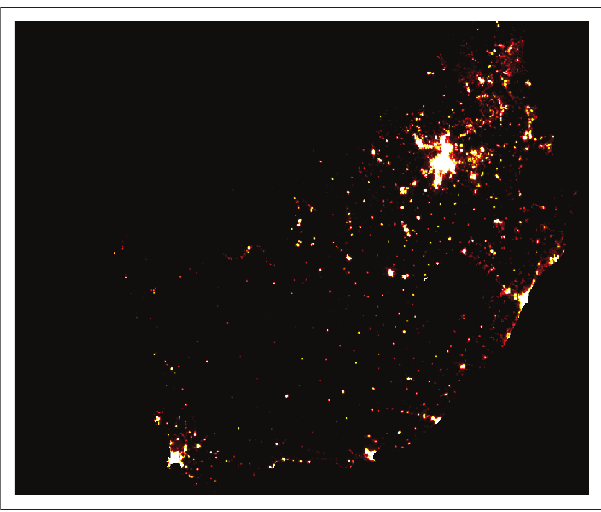
FIGURE 5: Suomi National Polar Partnership–Visible Infrared Imaging Radiometer Suite night-time lights South Africa,